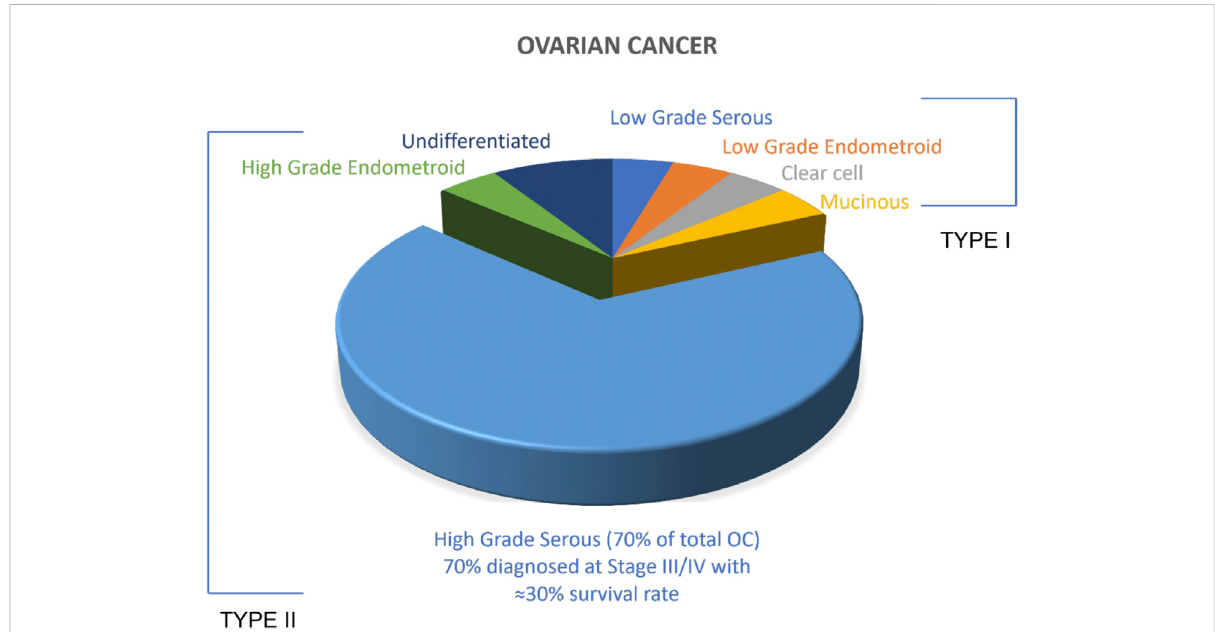
FIGURE 1 Ovarian Cancer types. All tumours associated with OC have been broadly classi fi ed into two subtypes: Type I and Type II. Malignant Type II comprises > 85% of the total OC.